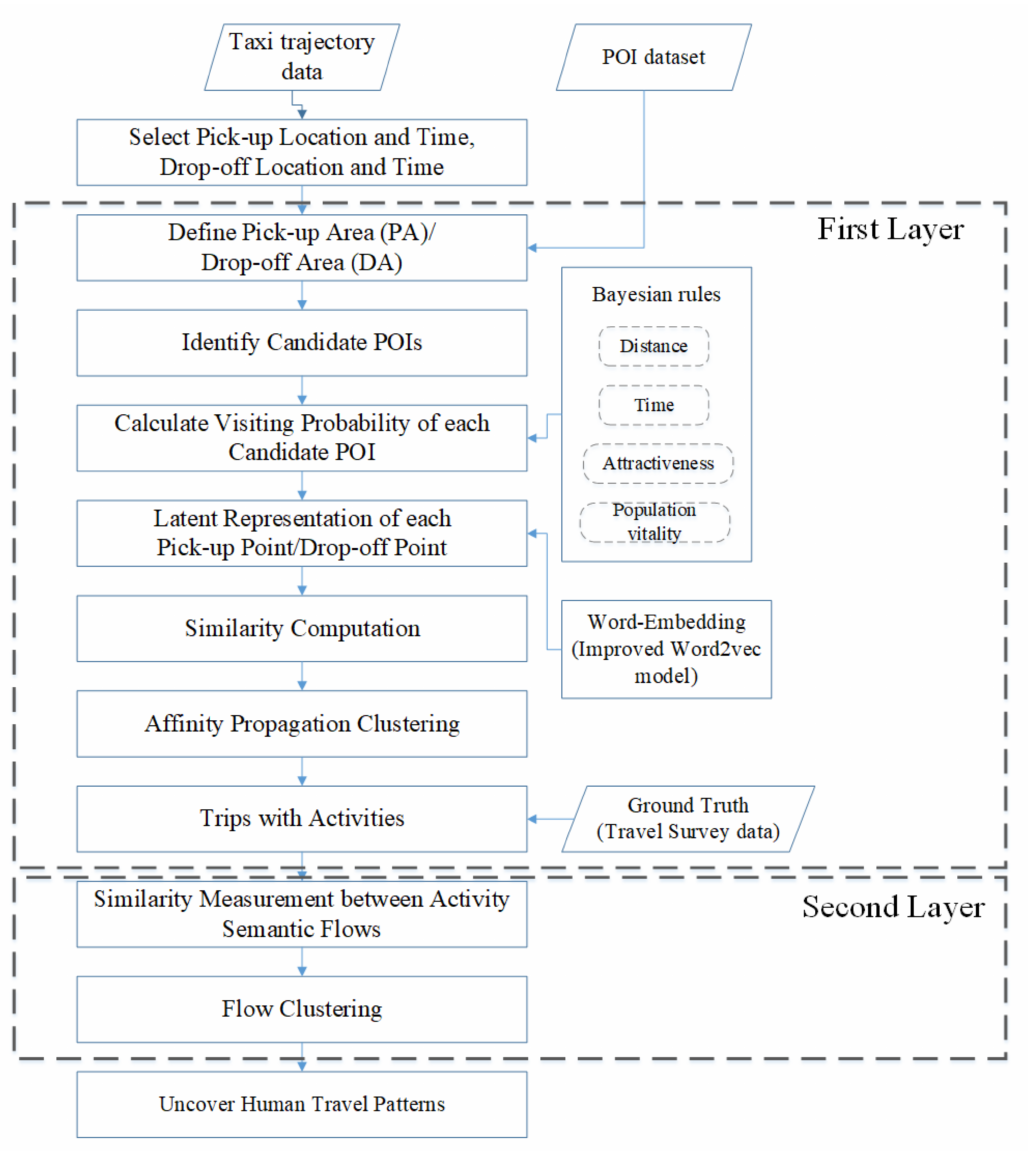
Figure 2. Framework of the proposed method: activity inference (First Layer); and flow clustering (Second